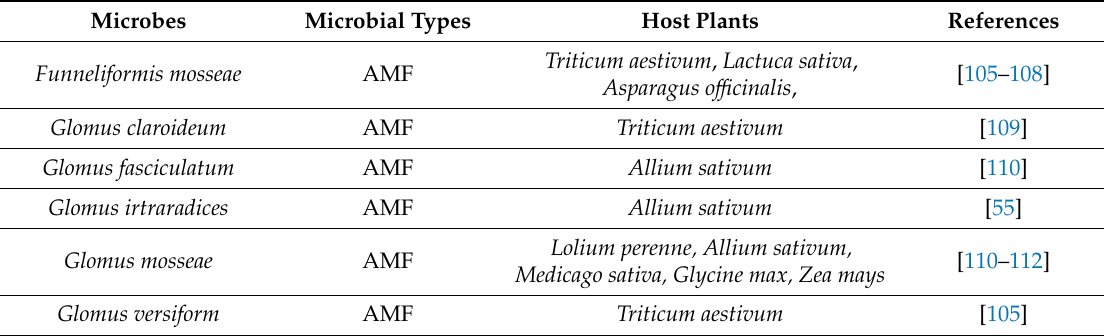
Table 1. Arbuscular mycorrhizal fungi (AMFs) and root endophytic fungi (REFs) often used for Se